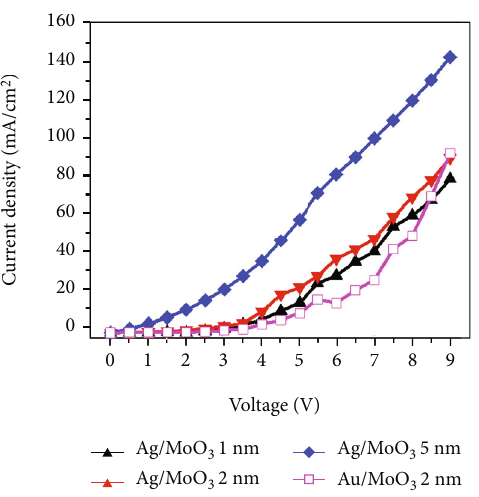
Figure 10: Overall comparison of I-V properties of Ag/MoO (di ff erent thicknesses) with Ag/Au/MoO